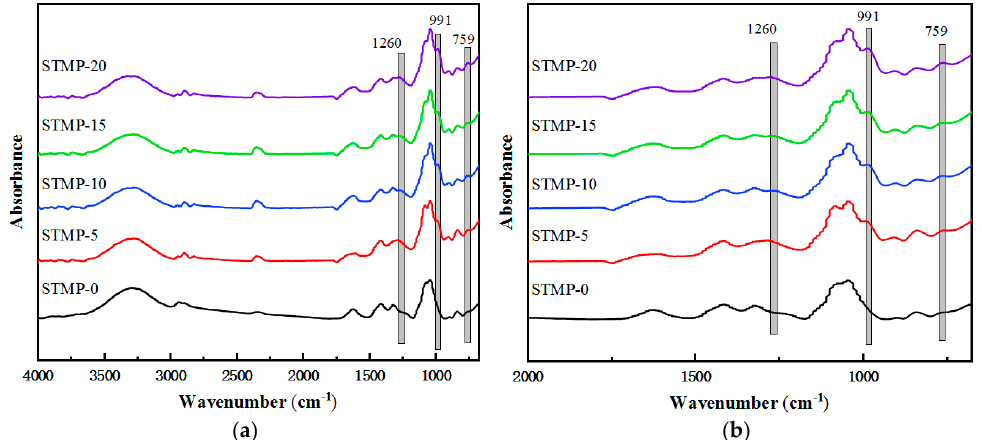
Figure 3. ( a ) FT − IR spectra of the STMP crosslinked hemicellulose films; ( b ) Fingerprint region of the FT − IR spectrum of STMP crosslinked hemicellulose films